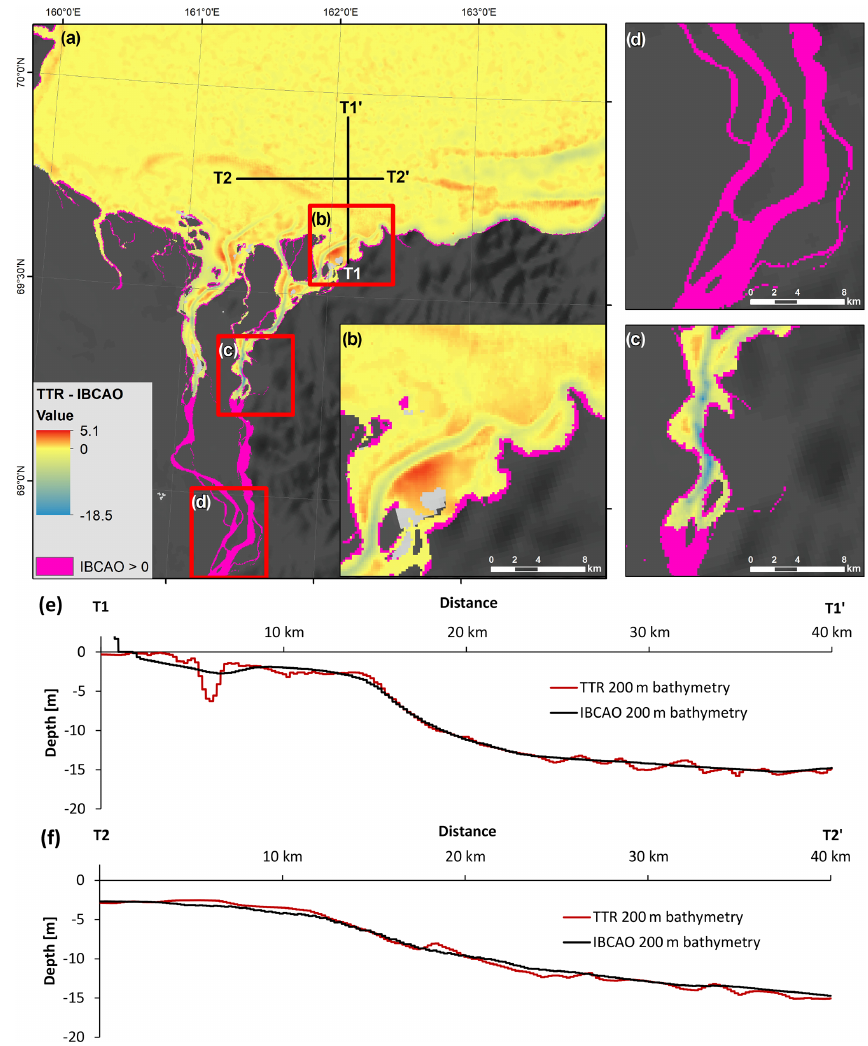
Figure 9. Depth difference map for the TTR 200 bathymetrical model and the IBCAO v4 200m bathymetrical data set in the Kolyma Gulf region (TTR 200 minus IBCAO v4). Purple zones show areas where the IBCAO v4 incorrectly provides values above sea level. Reddish areas depict zones where the IBCAO v4 overestimates the depth in comparison to the TTR 200 . Blueish areas show zones where the IBCAO v4 has lower water depths than the TTR 200 . The highest positive value (5.1m, red) means that the IBCAO v4 indicates a depth which is 5.1m deeper than in the TTR 200 . Panels (e) and (f) show cross-sections deriving depth data from both data sets (TTR 200 in red and IBCAO v4 in black) in the near-shore zone, directly comparing the TTR 200 and the IBCAO v4 bathymetrical model, indicating a generally good agreement between the two data sets with the exception of deep main river channels (e)